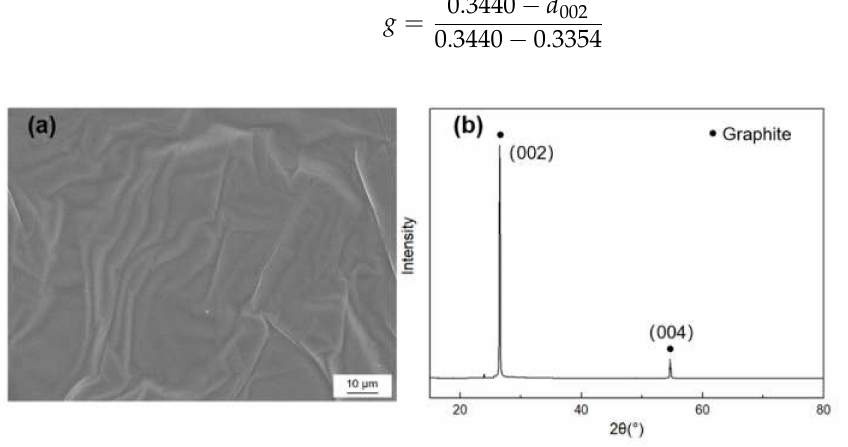
Figure 1. ( a ) SEM morphology and ( b ) X-ray diffraction (XRD) pattern of the graphite film. Here, g is the graphitization degree, d 002 is the average layer spacing of crystal face, the layer spacing of the ideal graphite crystal is 0.3354 nm and the layer spacing of amorphous carbon is 0.344 nm. The crystallite parameters of graphite film are listed in Table 1, and the in-plane and axial TC of the graphite films were measured to be 1189 W/m · K and 18 W/m · K,